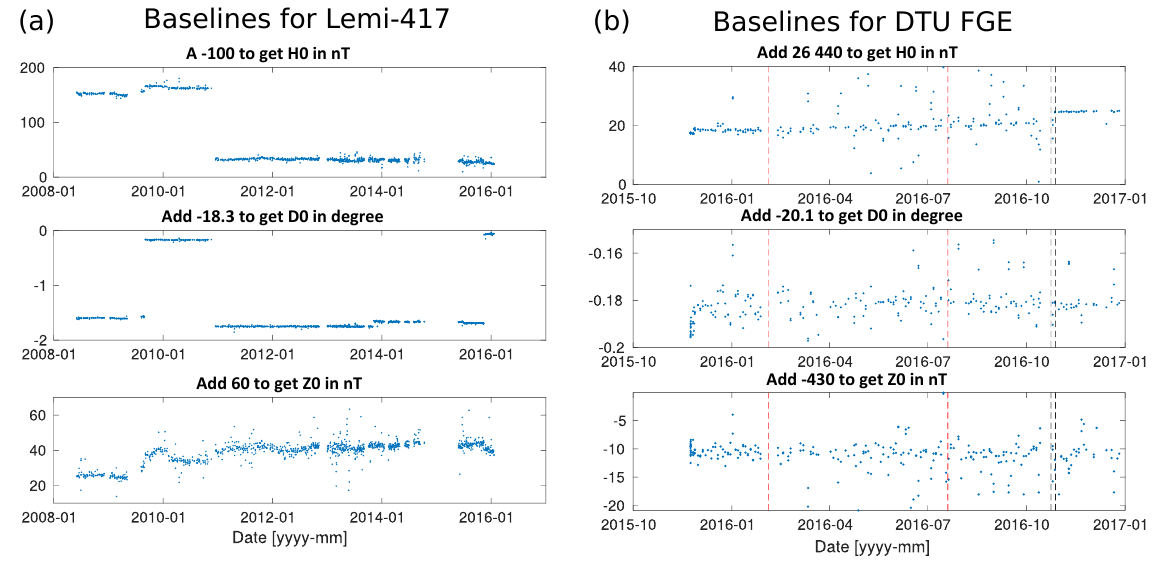
Figure 10. Base values for the Tatuoca observatory are shown for (a) the LEMI-417 variometer, and (b) the DTU FGE variometer. For the period between the vertical red lines, regular data download was not available. Further, vertical black lines indicate the visit to Tatuoca in October 2016.